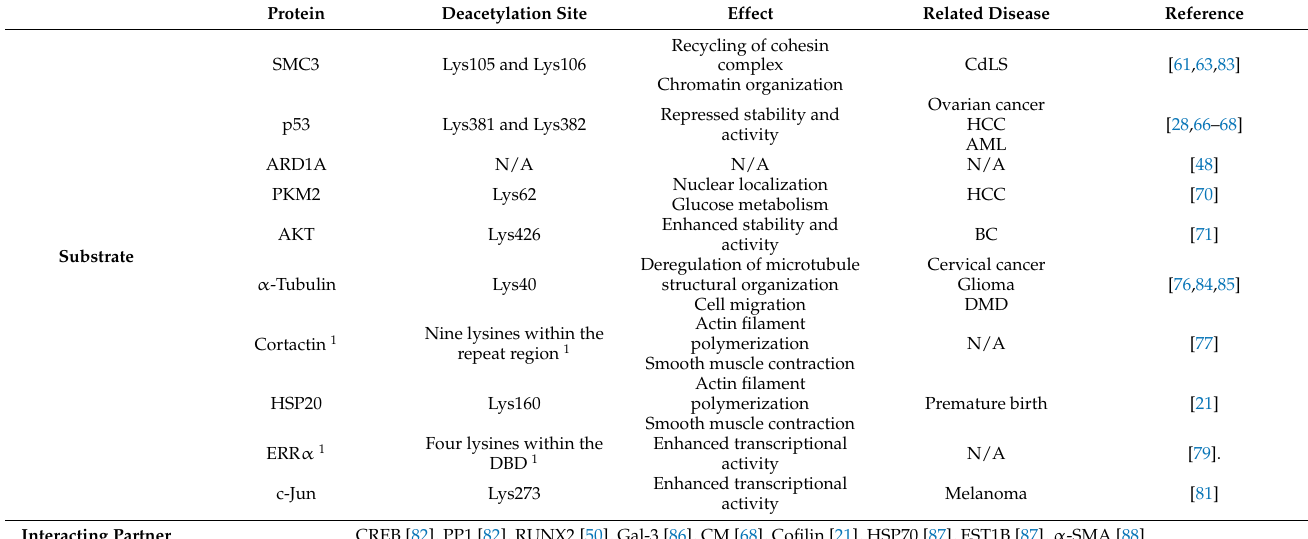
Table 2. HDAC8 substrates and interacting